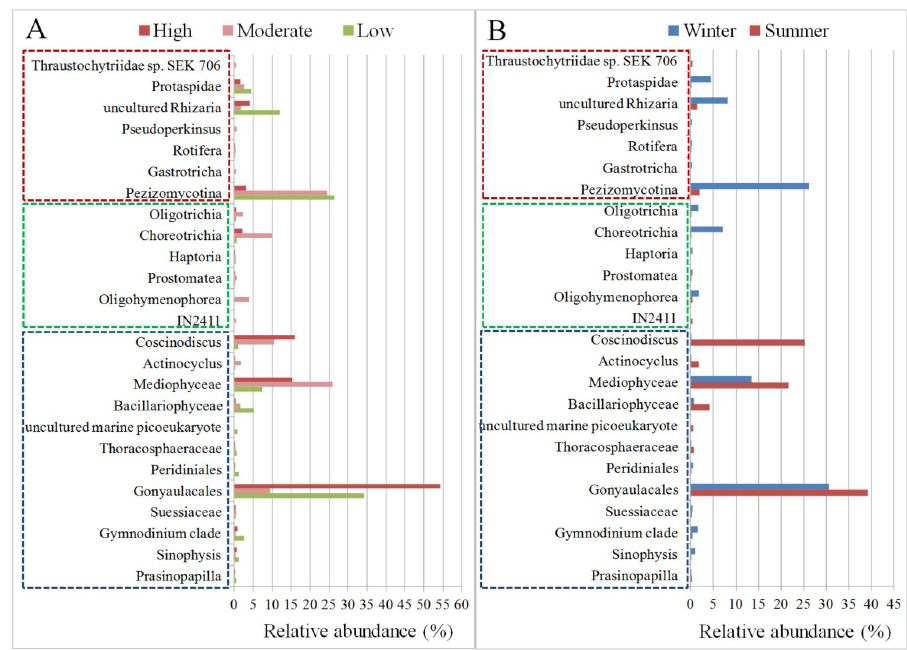
Fig 8. The relative abundance of eukaryotic microbial taxa based on the degree of anthropogenic changes (A) and season (B). Taxa with an overall abundance of > 0.1% are shown. The different groups of organisms are marked with different color dotted boxes. Blue dotted box: Algae; Green dotted box: Ciliates; Red dotted box: Fungi, protists, and other microscopic eukaryotes.